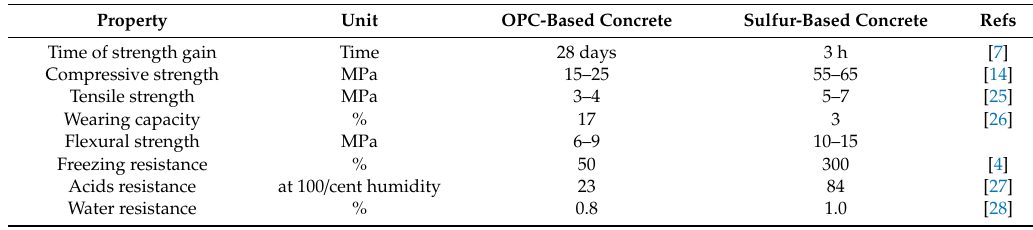
Table 1. Comparison between Ordinary Portland Cement (OPC)-based concrete and sulfur-based concrete properties (grade M15 and